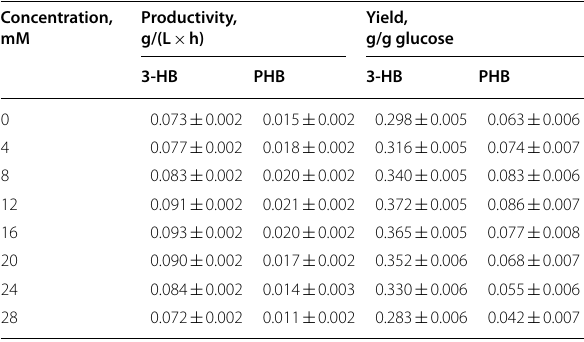
Table 3 The productivity and yield of 3-HB and PHB at different Na SO 2 4